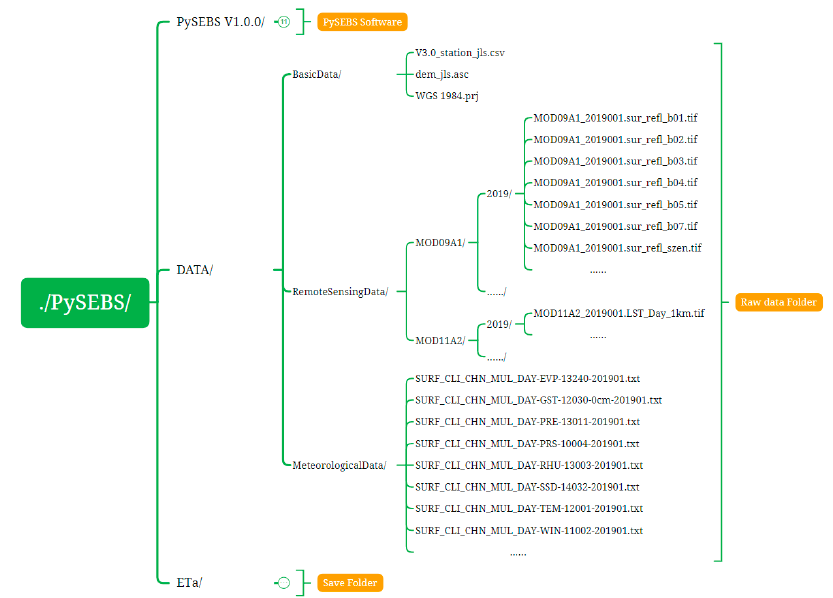
Figure 3. Structure of the path to the initial input data.